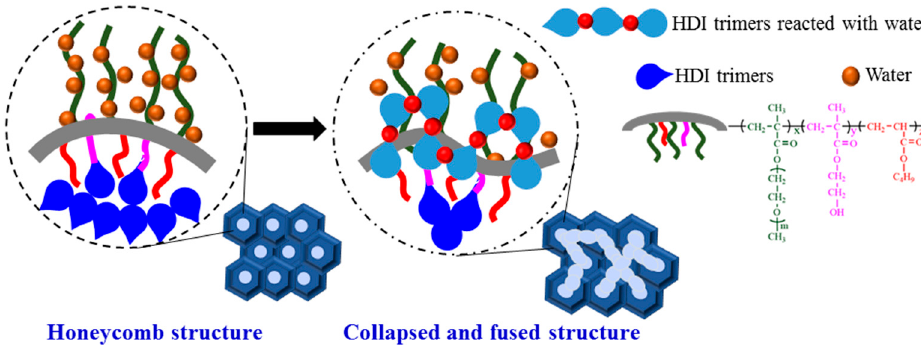
Figure 6. Schematic process of the collapsing and fusion of honeycomb structure.